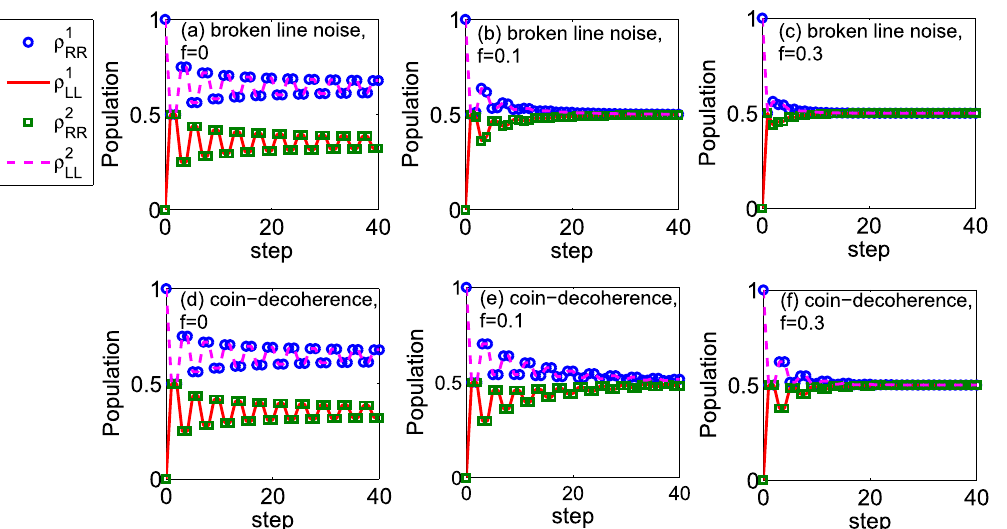
Figure 3. The populations of the coin in the one dimensional QW with different decoherence strengths. Blue circles and red solid line describe the populations of the coin at the state | R 〉 and | L 〉 , respectively; the initial coin state is ρ = R R (0) . Green rectangles and magenta dashed line represent the populations of the coin at the 1 state | R 〉 and | L 〉 , respectively; the initial coin state is ρ = L L (0) . ( a – c ) The broken line noise is considered in 2 the walk. ( d – f ) The coin-decoherence emerges in the